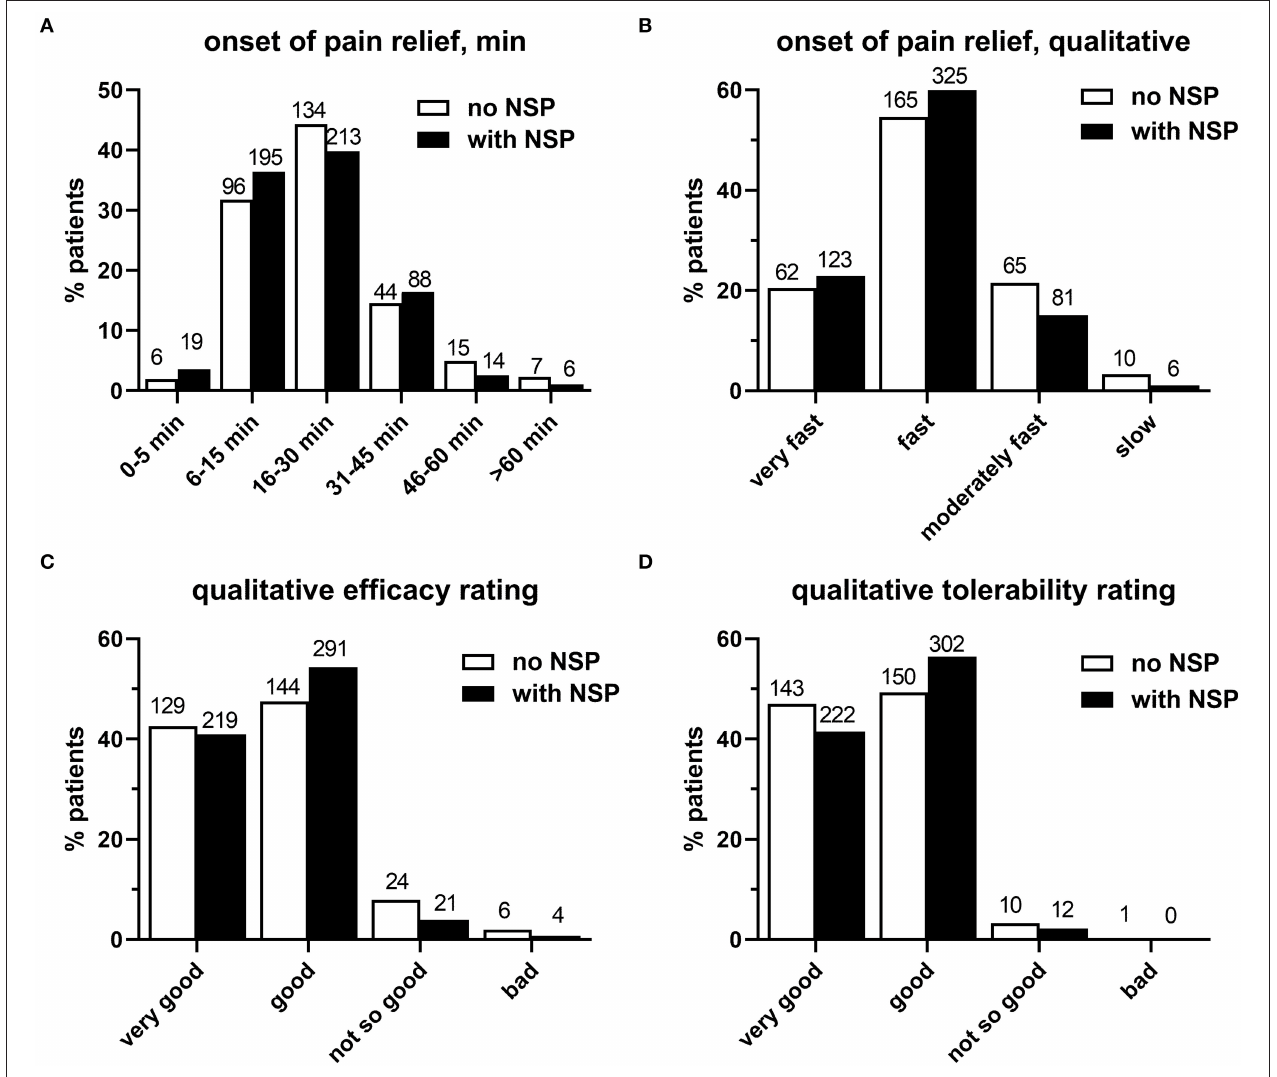
FIGURE 3 | (A) Onset of pain relief. (B) Patient ratings of speed for the perceived onset of pain relief. (C) Patient ratings for IbuCaff efficacy. (D) Ratings for IbuCaff tolerability. The numbers of patients for the different groups are shown on the top of